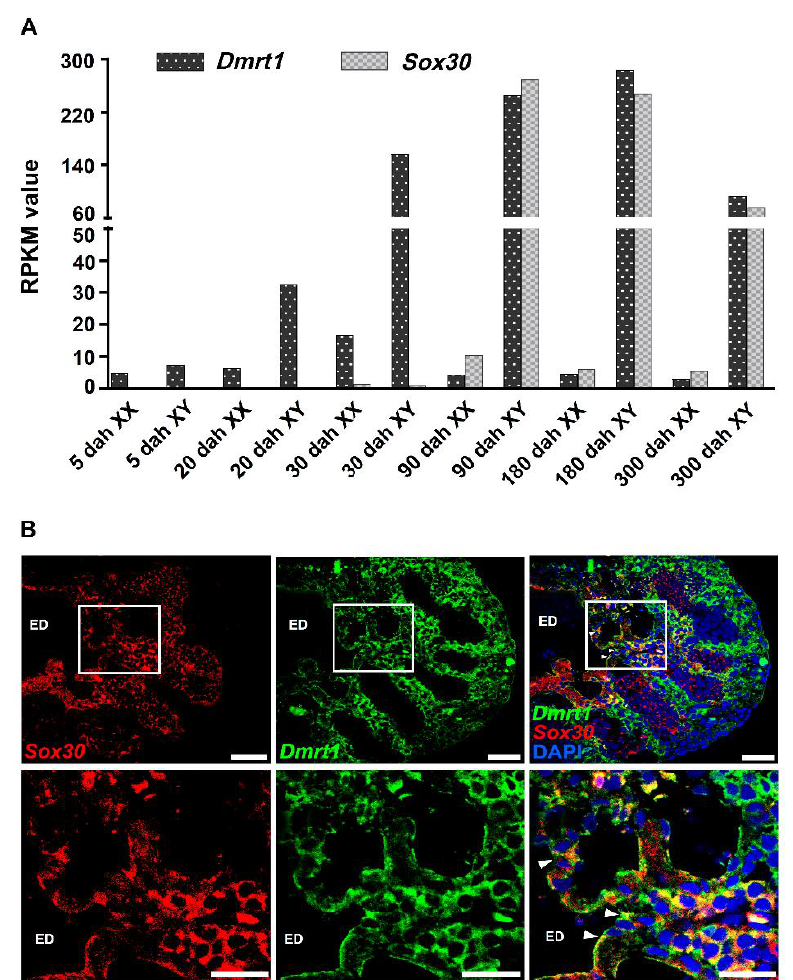
Figure 2. Expression patterns of Sox30 and Dmrt1 in the Nile tilapia testis. ( A ) Transcriptome-based analysis of expression patterns of Sox30 and Dmrt1 in the gonads of the Nile tilapia during different developmental stages. The Reads Per Kilobase per Million mapped reads (RPKM) value was used to evaluate the expression level. dah, days after hatching; XX, female gonad; XY, male gonad. ( B ) Fluorescent in situ hybridization analysis of expression patterns of Sox30 and Dmrt1 in the gonads of male Nile tilapia at 90 dah. Double-colored fluorescent in situ hybridization was carried out on cross sections of male gonads at 90 dah. The below images were separately enlarged according to the regions indicated above images. The result shows that Sox30 and Dmrt1 are co-expressed in the epithelial cells comprising the efferent duct. White arrowheads indicate epithelial cells. scale bars =20 μm. ED, efferent duct.